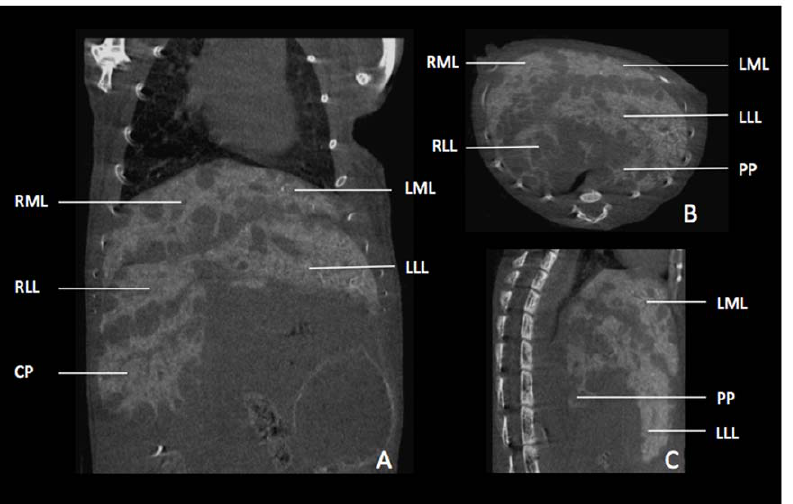
Figure 8. Illustrative micro-CT images of liver metatstases in a mouse. A–C Images of liver metastases were acquired 2 hours after i.v. injection of 100 m l of a contrast agent (Viscover Exitron nano 6000; Miltenyi Biotec, Bergisch-Gladbach, Germany) in a coronal (A), transversal (B), and saggital (C) slice orientation. With regard to liver anatomy, we found metastases to develop predominantly under the liver capsule adjacent to the fissures between the liver lobes. While the left lateral lobe (LLL) shows no metastases on its caudal edge in this slice, there are plenty on its cranial edge, next to the left medial lobe (LML). The lobes on the right side (right medial lobe (RML), right lateral lobe (RLL) and the caudate process (CP)) show (besides the subcapsular growth pattern) metastases within the liver parenchyma. Due to tumor growth the papillary process depicted in B and C lost its typical shape (compare with figs. 2, 3, 4).